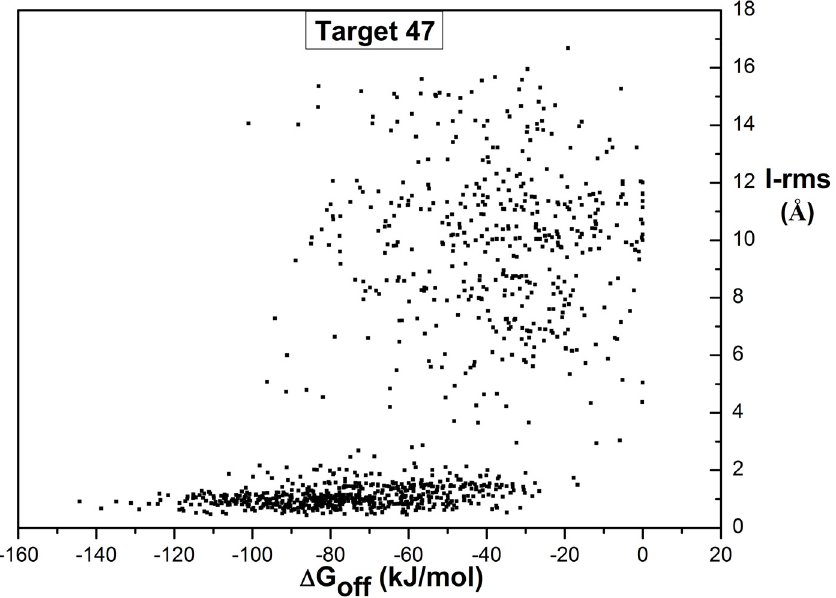
Fig 1. Distribution of 4 G off over all structures vs. interface quality parameter I_rms (Target 47). Each dot represents one structure in the Score_set of Target 47. The x axis shows the RMSD of backbone atoms of interface residues between docking decoys and crystal structures (I_rms); the y axis shows 4 G off which describes the predicted binding strength. Same plots for other targets are in S1